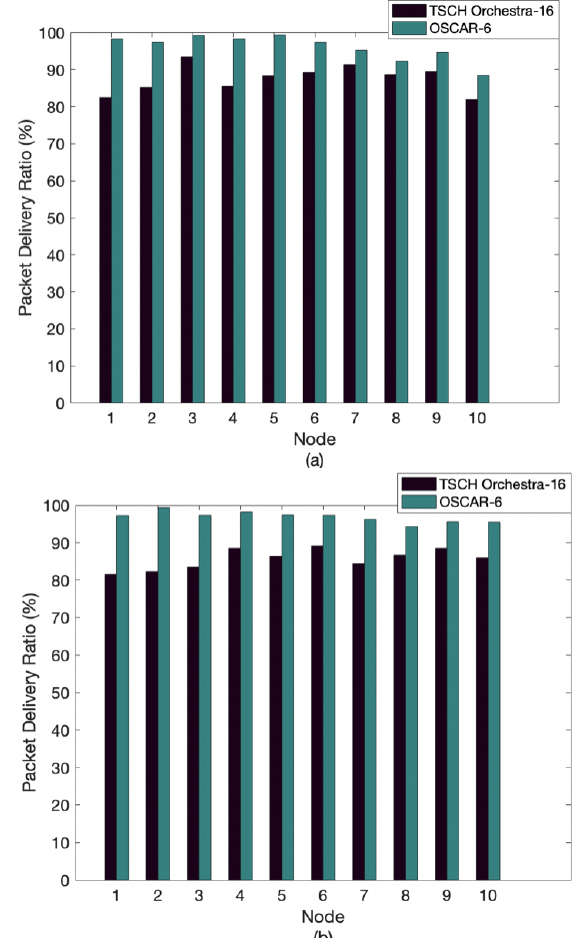
Figure 7. Average packet delivery ratio of OSCAR and Orchestra: ( a ) first topology and ( b ) second